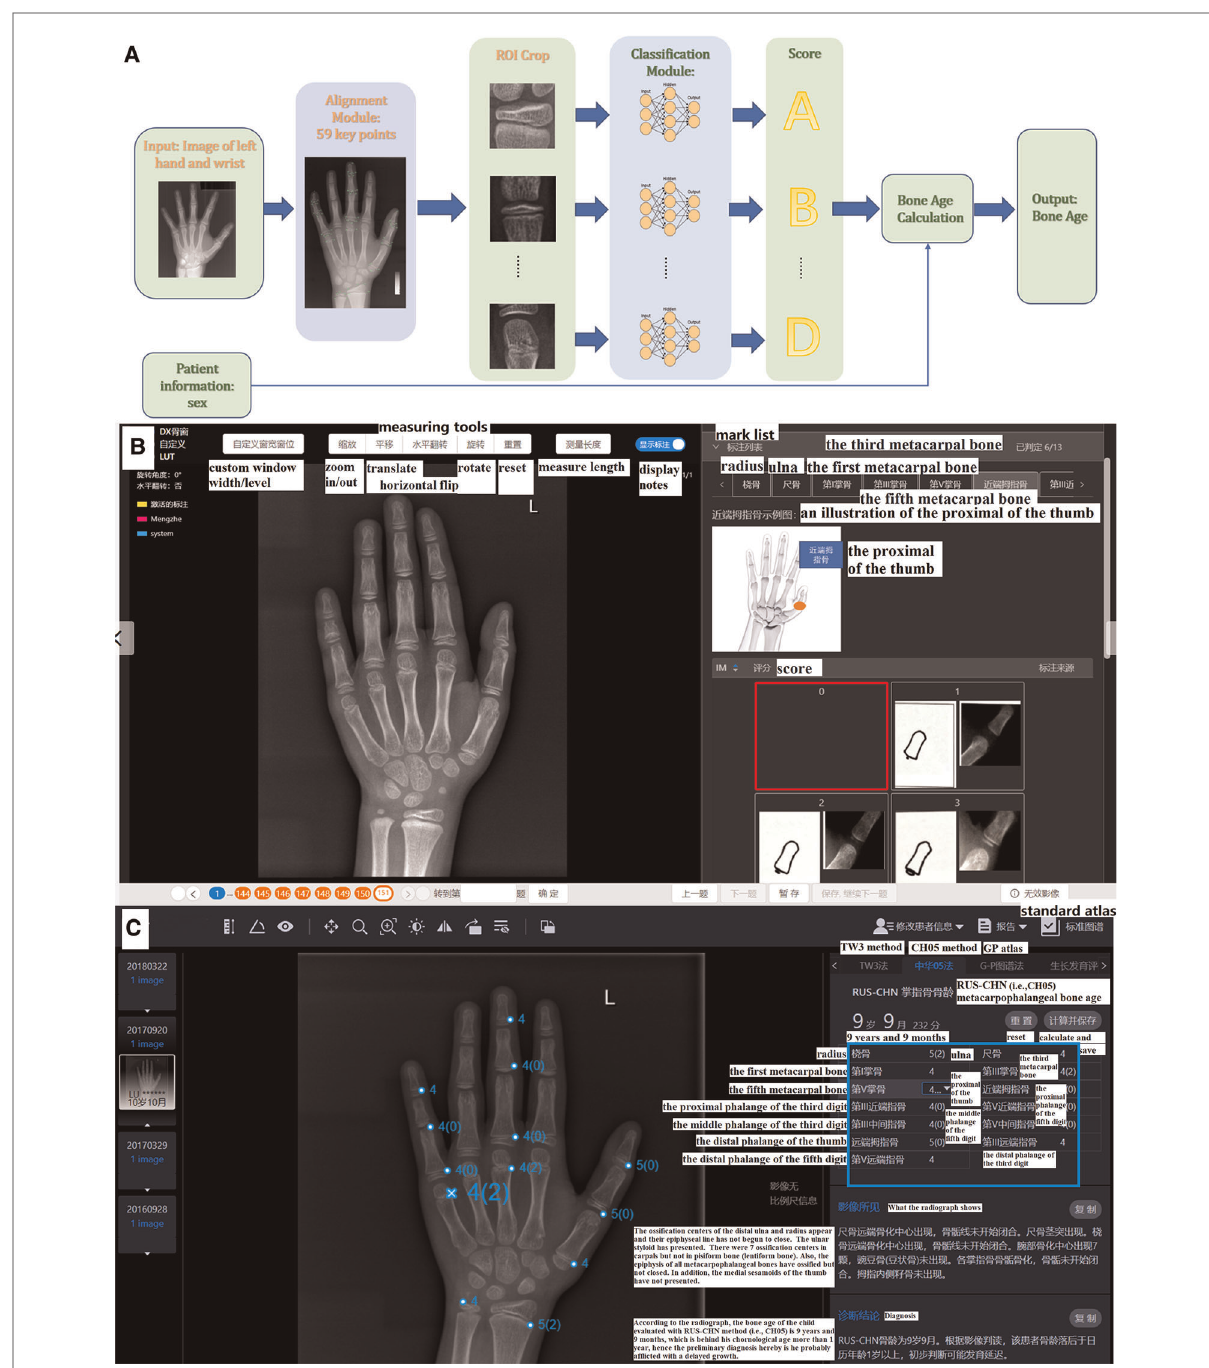
FIGURE 2 ( A ) Network structure of the region-based convolutional neural network. Two modules, including alignment and classi fi cation modules, adopted a deep residual network (ResNet) to evaluate bone age automatically. ( B ) The product window for doctors to evaluate bone age without AI assistance. Taking the proximal of the thumb as an example, the rater compares the patient ’ s radiograph shown in the middle of the picture (by using the measuring tools in the upper middle such as zoom in/out) with the standard atlas (in the bottom right) and choses 0 – 8 points (marked as a red box) for it accordingly. In total, there are 13 ossi fi cation centers (i.e., the mark list as shown in the upper right including radius, ulna and so on) need to be scored and the bone age will be calculated automatically. ( C ) The product window for doctors to con fi rm and modify bone age with AI assistance. AI has scored the 13 ossi fi cation centers before raters ’ evaluation (as presented in the blue box), and then raters begin to check each center according to atlas of CH05 which would show with a click of the button of standard atlas. When discrepancy appears, raters would re-compare with the standard atlas and decide to revise or remain the score accordingly. Finally, bone age is automatically calculated after a click of save button. Here the reader tends to score 4 points for the fi fth metacarpal bone based on CH05 while it rated as 4(2) by AI, and a fi nal 4(2) points was decided after a re-check with the standard atlas by the